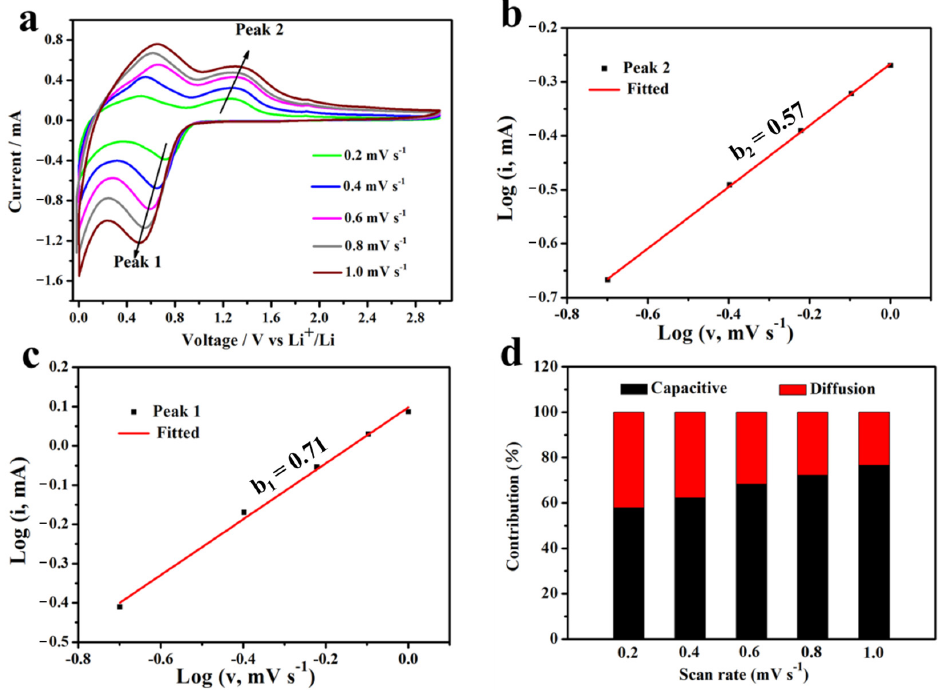
Figure 7. ( a ) CV curves of Zn 2 GeO 4 -150 electrode at di ff erent scan rates ranging from 0.2 to 1 mV s − 1 , ( b , c ) the corresponding plots of log(𝑖) versus log(𝑣) , ( d ) contribution ratio of capacitive and di ff u- sion-controlled behaviors at various scan rates.